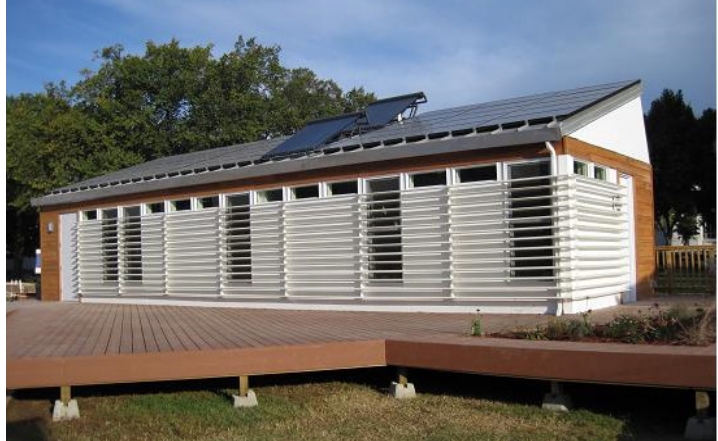
Figure 1. Team Missouri’s 2009 Solar Decathlon